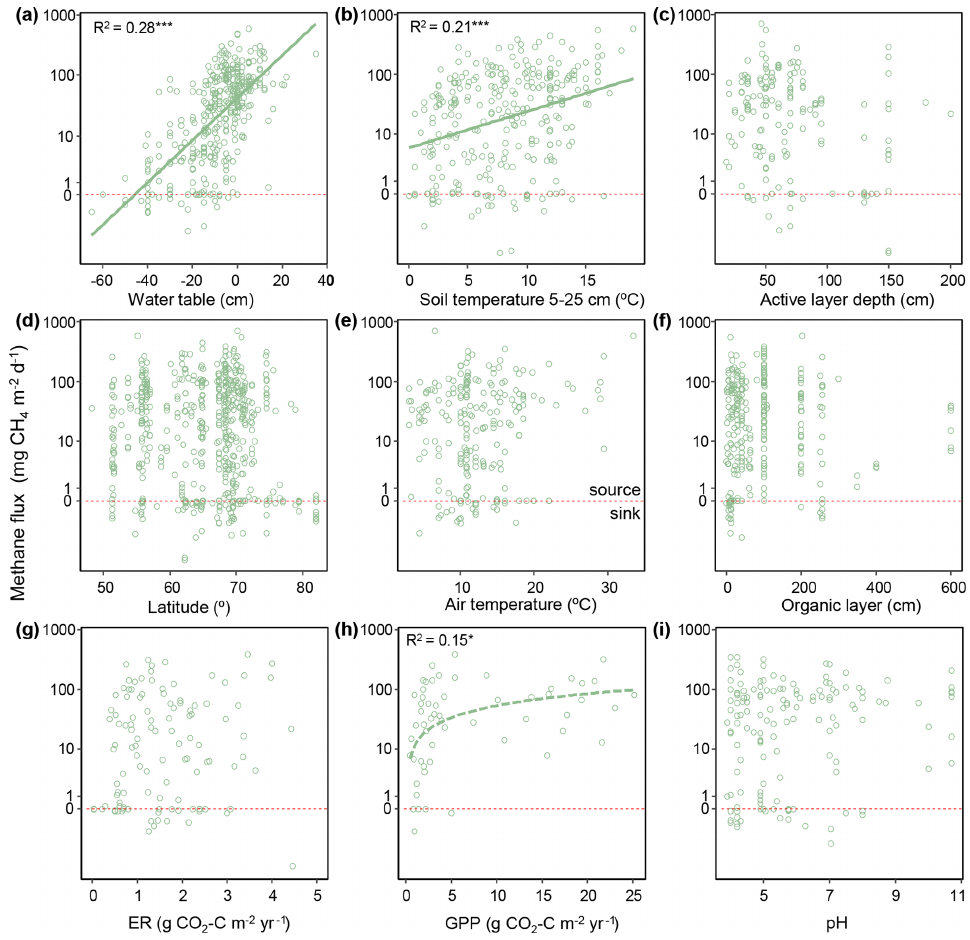
Figure 7. Relationships between site-averaged warm-season CH 4 flux and environmental variables. Environmental variables include water table, soil temperature at 2–25cm depth, active layer depth, latitude, air temperature, organic layer thickness, ecosystem respiration (ER), gross primary productivity (GPP), and soil pH. Regression lines and R 2 values are shown for significant relationships. Note the log scale. CH 4 flux was linearly related to water table and soil temperature and was logarithmically related to GPP (dotted line). Points below the dotted red line represent net uptake fluxes. ∗ P < 0 . 05, ∗∗ P < 0 . 01, ∗∗∗ P < 0 .